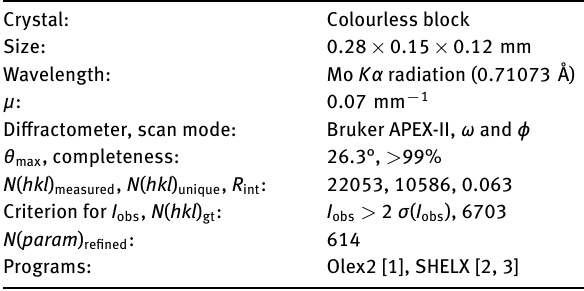
Table 1: Data collection and